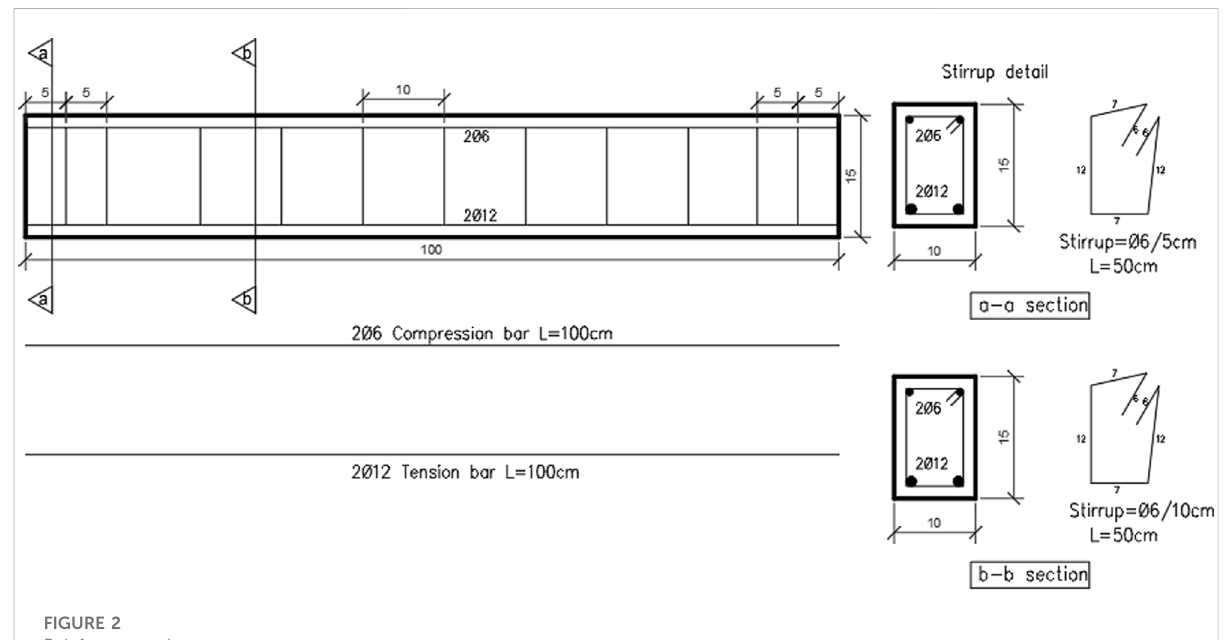
FIGURE 2 Reinforcement layout.